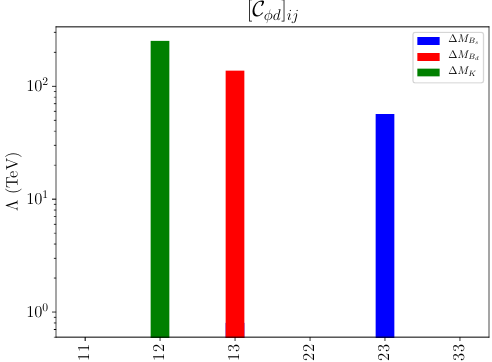
Figure 9 . The maximal NP scale Λ for (cid:2) (cid:3) M ij / (∆ M ij ) exp for B s (blue), B d (red) and K 0 (green), respectively. 2 12 BSM